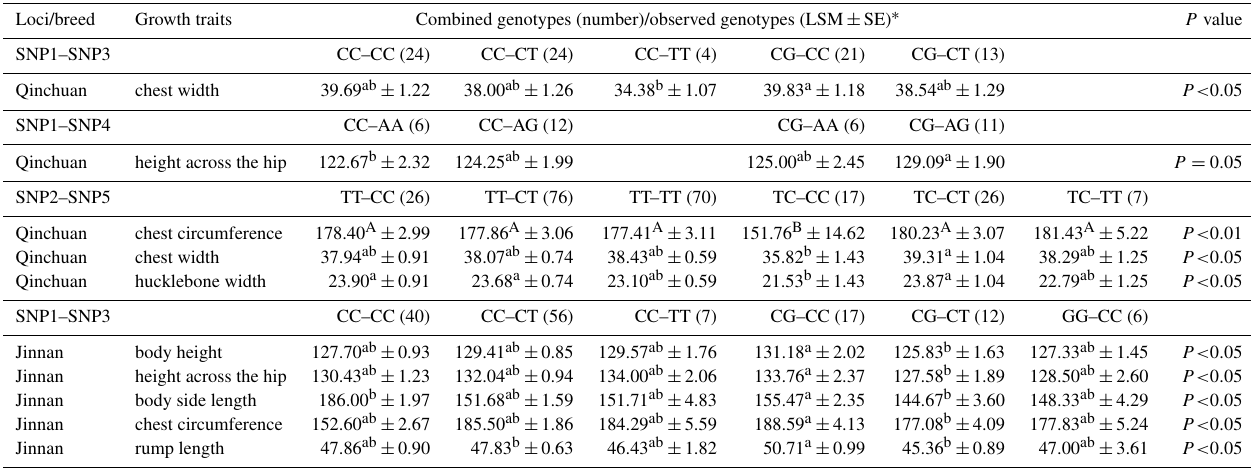
Table 6. Associations between combined genotypes and growth traits in Qinchuan and Jinnan cattle. Loci/breed Growth